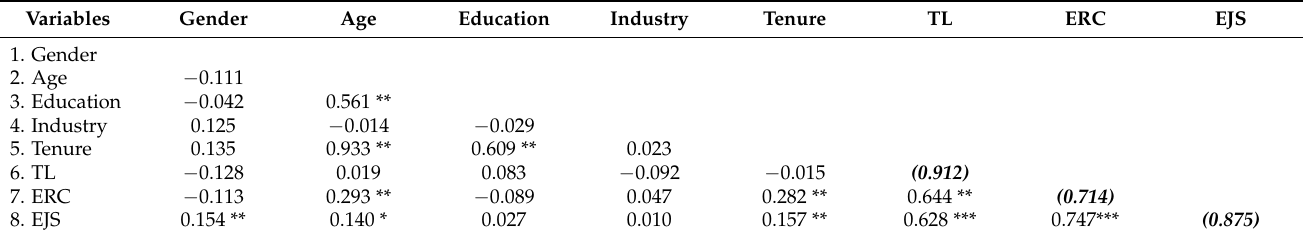
Table 2. Correlations and